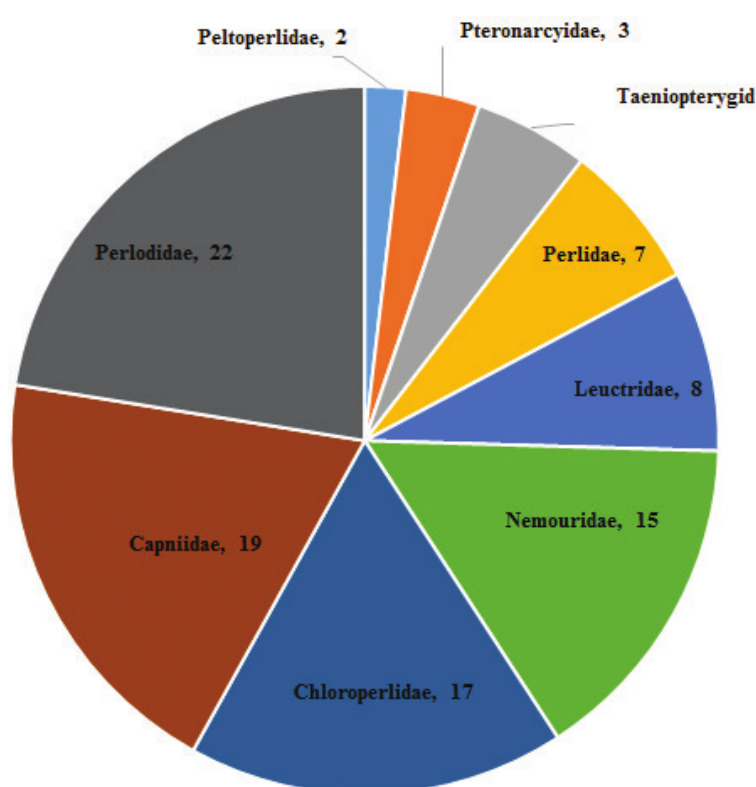
Figure 1. The percent of the Canadian Plecoptera fauna represented by each family. The numbers repre- sent rounded percentages and do not total